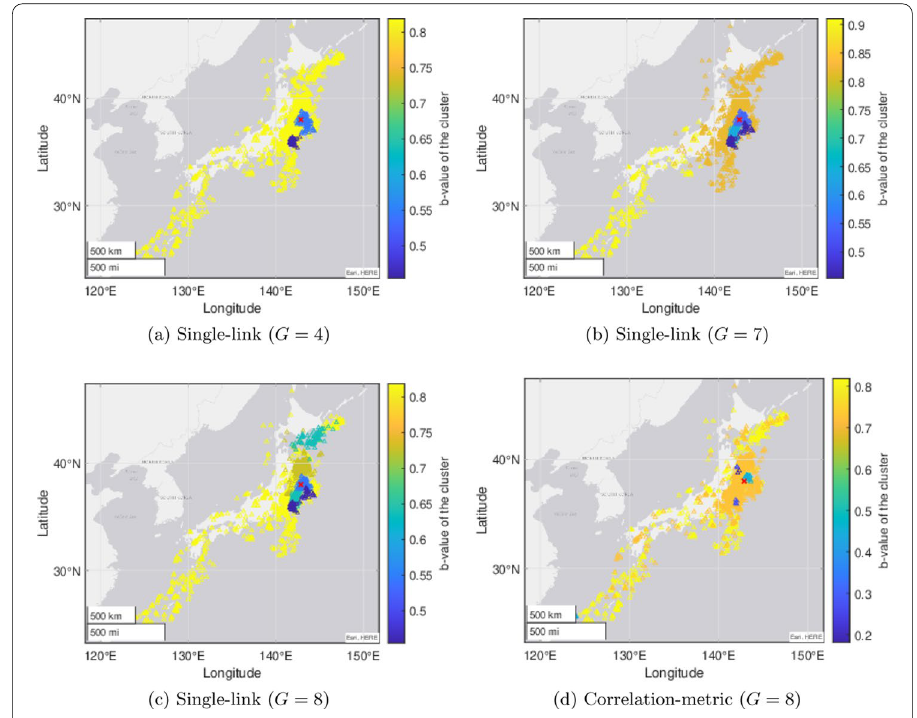
Fig. 4 Results of visual evaluation based on Variance f 1 ( R ) (the largest magnitude earthquake in Japan m max = 9.0 is indicated by red